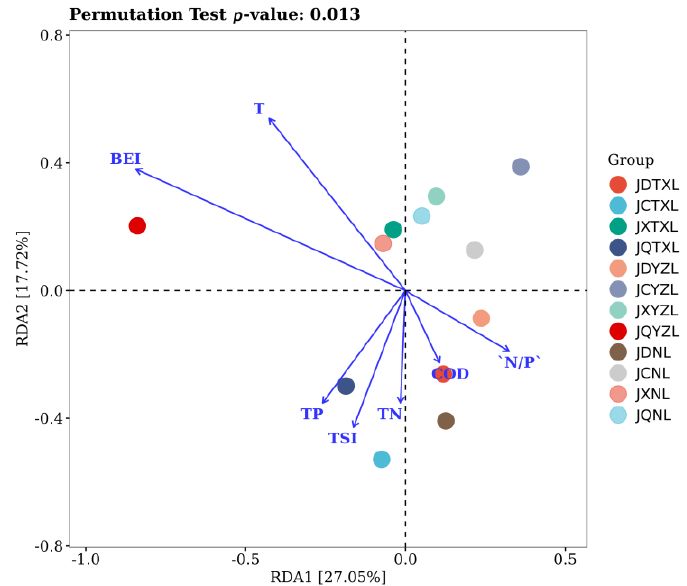
Figure 6. RDA analysis showing the relationships between bacterial communities and nutrient parameters. The water samples in spring, summer, autumn, and winter, respectively, are denoted as JCTXL, JXTXL, JQTXL and JDTXL for Tangxun Lake; JCYZL, JXYZL, JQYZL and JDYZL for Yezhi Lake and JCNL, JXNL, JQNL and JDNL for Nan Lake.